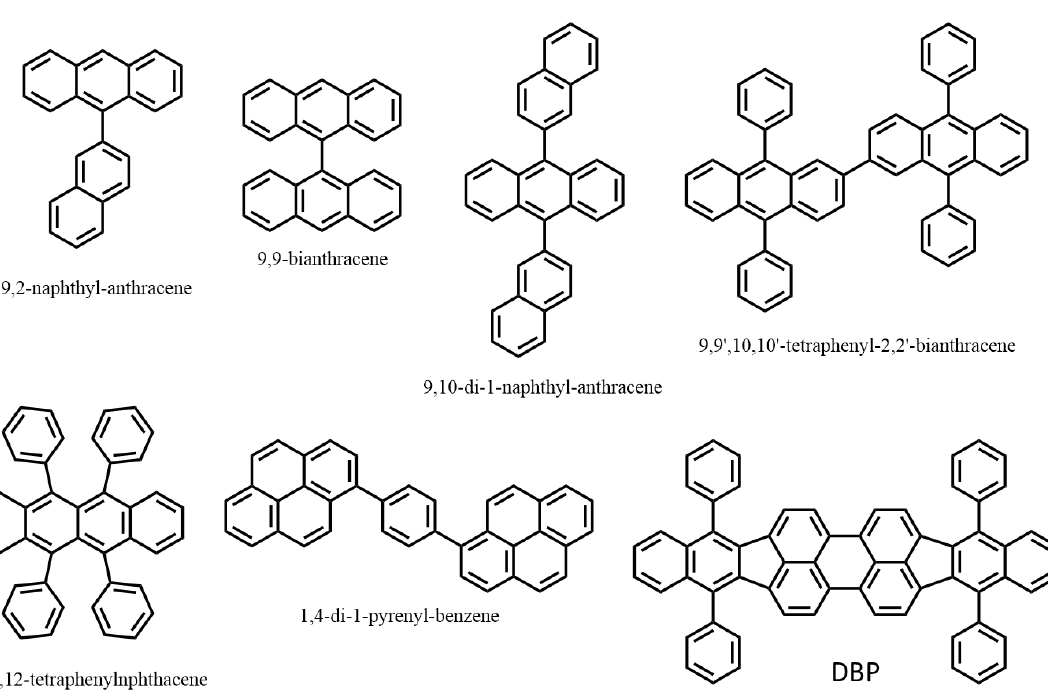
Figure 9. The non-heteroatom contains aromatic molecules, which report to Aro-3 and contain bridging C ar -C ar linkages, with the smaller aromatic cores consisting of three fused aromatic rings ( top row ) and those with four or more fused aromatic rings ( bottom row ).